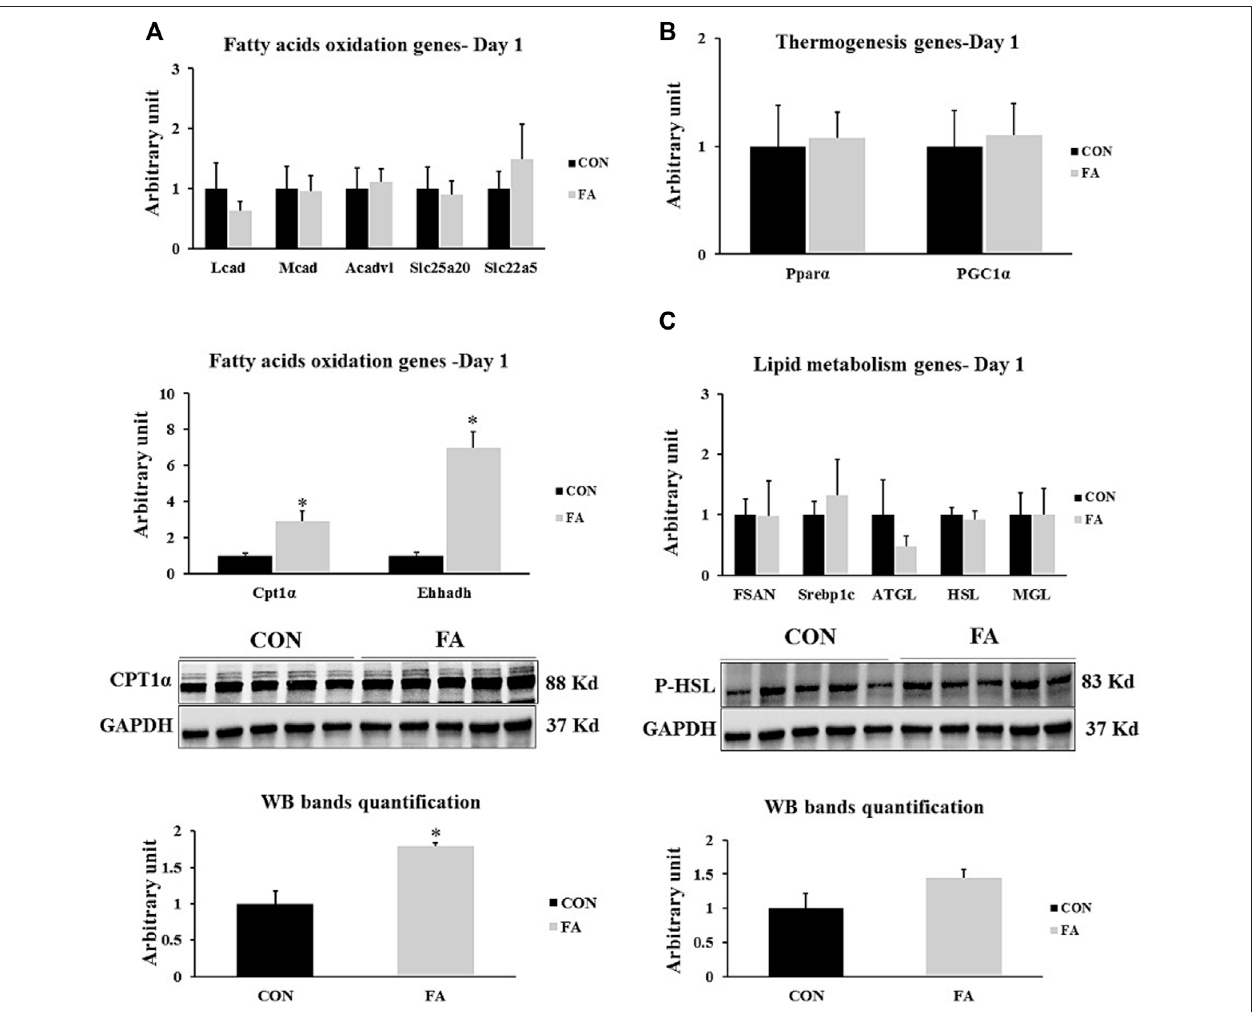
FIGURE 6 | Effect of maternal intake of EPA/DHA on lipid metabolism regulation in liver in day 1 neonates. The mothers were fed either control diet (CON) or EPA/ DHA enriched diet (FA) during the entire period of pregnancy and lactation (A) Quantitative RT-qPCR ( n = 8) and representative image and densitometric analysis of westernblot( n =5)ofgenesregulatingfattyaciduptakeanda β -oxidation( n =8) (B) Therelativeexpressionofgenesinvolvedinregulatingthethermogenesisprocessin liver ( n = 8). (C) Quantitative RT-qPCR ( n = 8) and representative image and densitometric analysis of western blot ( n = 4) of genes regulating lipogenesis and lipolysis. The control imageof GAPDH from liver samples (D1) was re-used. The raw Ct wasnormalized to the value of18 s. All data represent asmean ± SEM. p < 0.05 by Student ’ s t-test.